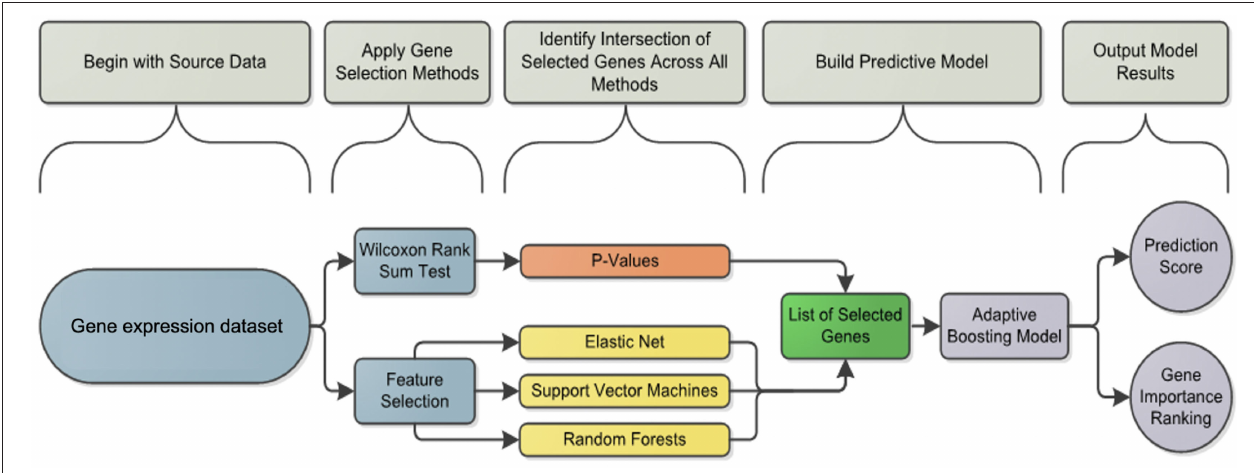
FIGURE 2 | Analysis framework flowchart: pipeline workflow for predicting the vaccine response. Differentially induced genes between responders and non-responders were selected using a machine learning feature selection based on three different algorithms and the Wilcoxon test for each cell subset and condition. The list of selected genes was used by the Adaptive Boosting algorithm to build the predictive model and calculate the prediction score.